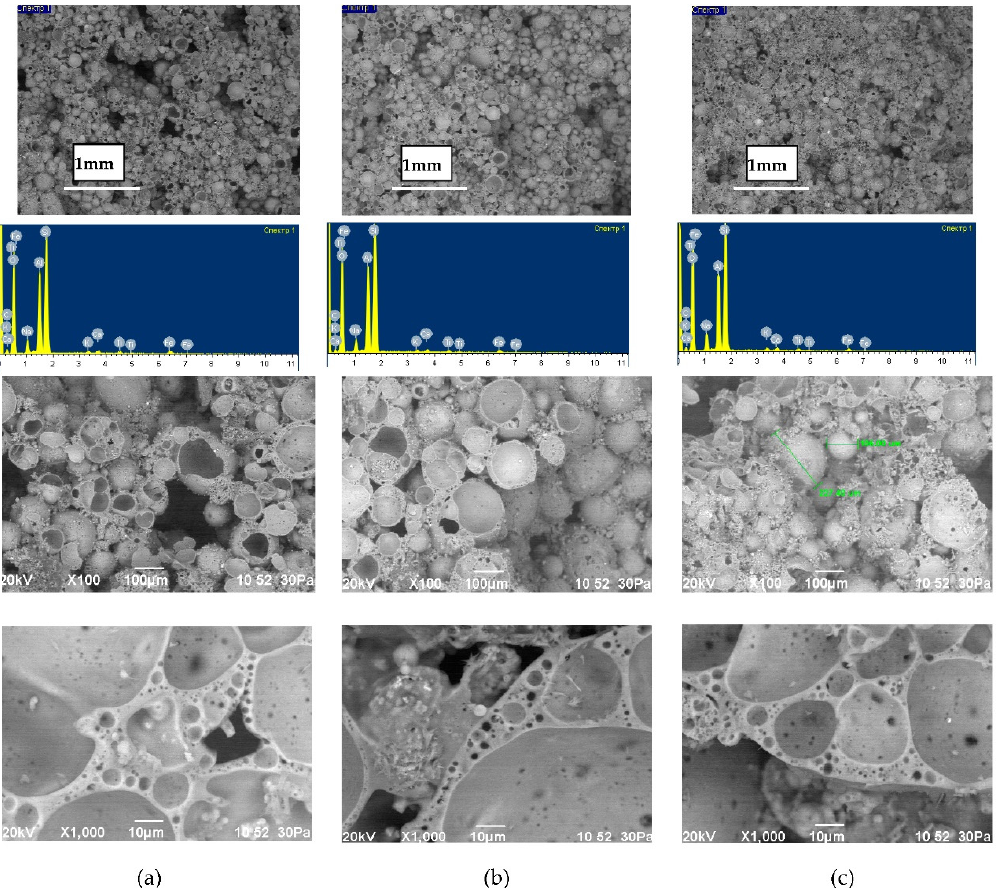
Figure 8. Microstructure of granules from a mixture of 10, fired at different temperatures, °C: ( a ) 150; ( b ) 250; ( c ) 350. ( b ) 250; ( c )